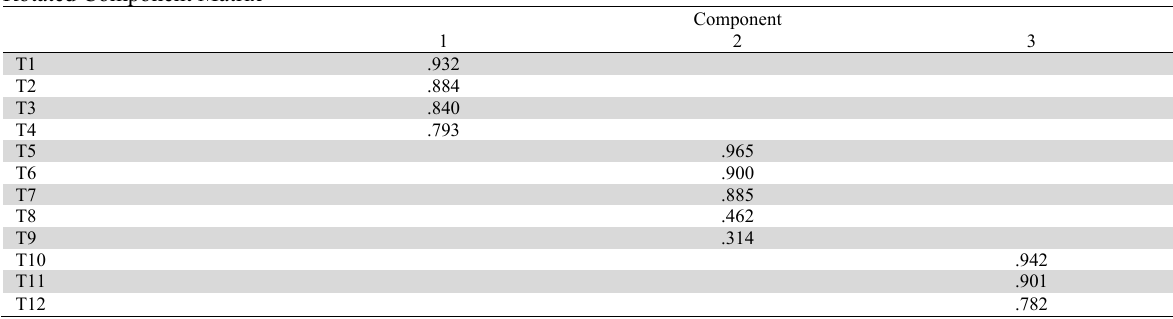
Rotated Component Matrix